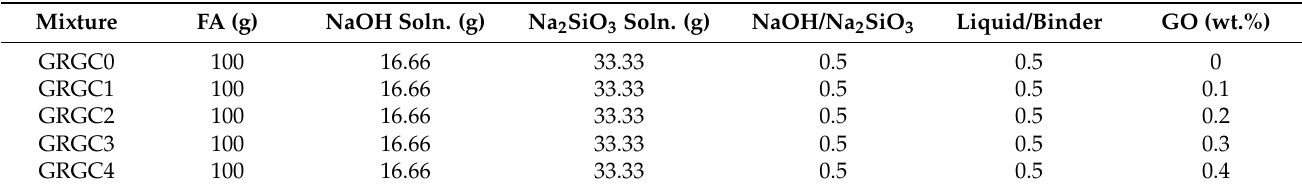
Table 1. GRGC mixture